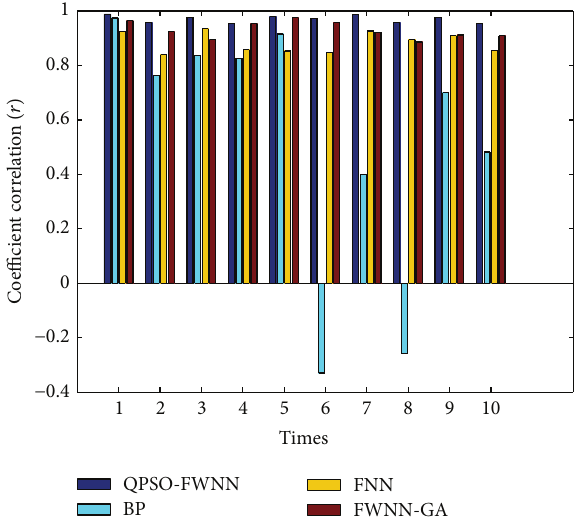
Figure 13: Coefficient correlation histogram of four prediction